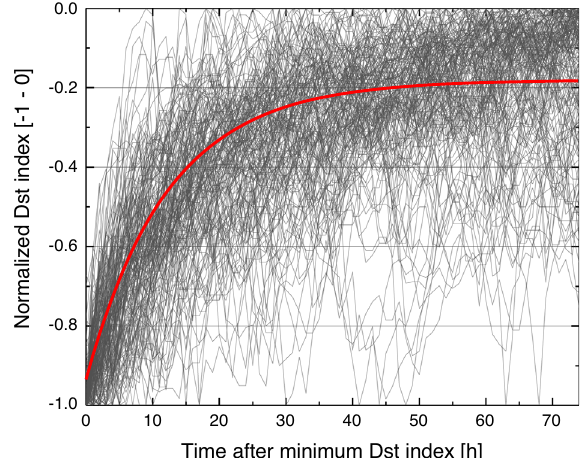
Fig. 4. The trend of the recovery phase of geomagnetic storms and results obtained from empirical equations. The Dst index is normalized by the absolute value of the minimum Dst index. Black solid lines show the normalized Dst index of the 184 events listed in Tables A.1 and A.2 in Appendix, and the red line is the result obtained from the recovery phase equation